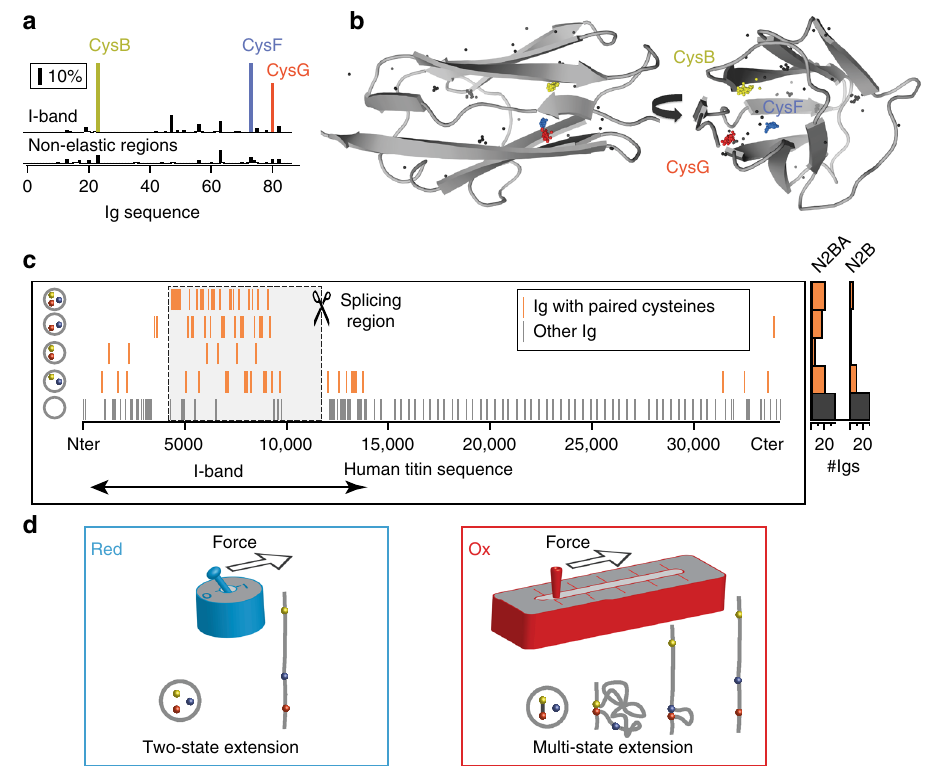
Fig. 6 Disul fi de isomerization in the Ig domains of titin. a Conservation of cysteines in the 163 Ig domains of the canonical titin. The upper histogram displays the cysteine percent conservation in the 101 Ig modules located in the I-band of titin. The lower histogram presents the percent conservation of cysteines in the 62 Igs in non-elastic regions (Z-Disk, A-Band and M-Band). The most conserved cysteines CysB, CysF and CysG, are shown in yellow, blue and red, respectively, and are over represented speci fi cally in the I-band. b Mapping of cysteines in the structure of Ig domains of the I-band of titin. This 3D map is obtained by superimposition of the 101 Ig structures (X-ray and homology models) belonging to the I-band. For clarity, only the structure of I91 is represented. Each cysteine is marked at its C β atom by a colored dot for the cysteines CysB (yellow, C23 ’ ), CysF (blue, C73 ’ ) and CysG (red, C80 ’ ) or a black dot for other cysteine positions. c Left: Each bar marks the position along the canonical titin sequence of domains with speci fi c distributions of CysB, CysF and CysG. These domains are concentrated in the I-band. Cardiac titin fi laments are expressed in two major isoforms, the long N2BA (3.7 MDa) and the shorter N2B (2.97 MDa) 28,51,52 . The section highlighted by the dashed line, which spans between exons 50 and 219, is highly spliced and totally absent in the N2B isoform. Right: The histogram displays the change of the relative populations of the different domains in the two major isoforms of cardiac titin (see also Supplementary Note 6). d Model of extensibility of Ig domains in the I-band. Mechanical unfolding of disul fi de-free Ig modules ( “ Red ” ) results in full extension of the polypeptide. In contrast, the mechanical extension of oxidized Ig domains containing the cysteine triad ( “ Ox ” ) is also determined by isomerization and reduction reactions. We propose that disul fi de bonds in titin act as a redox-sensitive mechanical potentiometer that can fi nely tune titin ’ s